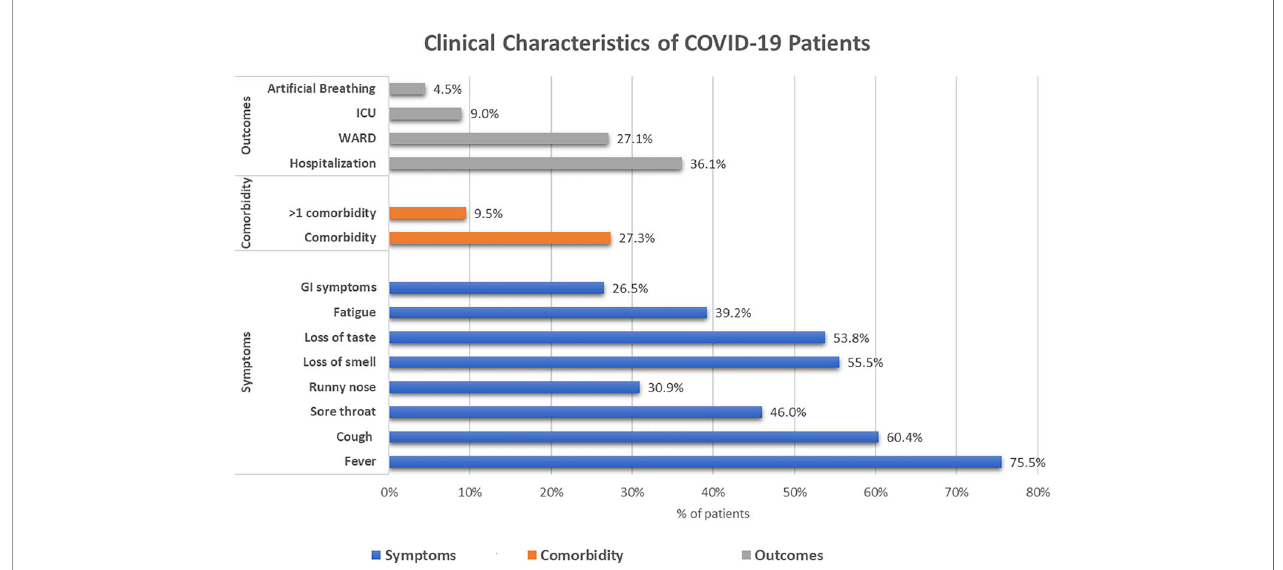
FIGURE 2 | Clinical characteristics of the COVID-19-infected subgroup within the cohort. The blue bars represent the symptomatic presentations of the patients, the orange bars represent the presence of comorbidities, and the grey bars represent the outcomes of the